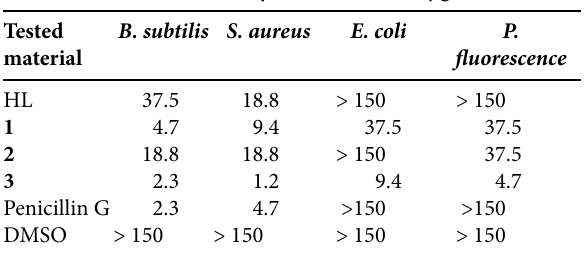
Table 3. Antimicrobial activities of the compounds Minimum inhibitory concentrations (μg mL –1